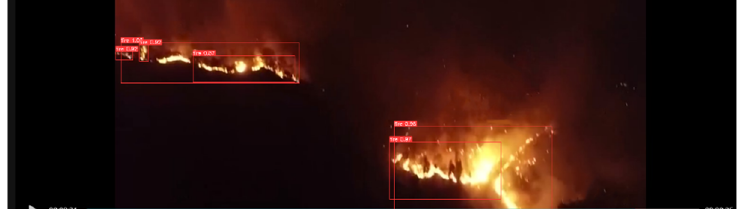
Figure 17. Real-time detection result using a forest fire video.